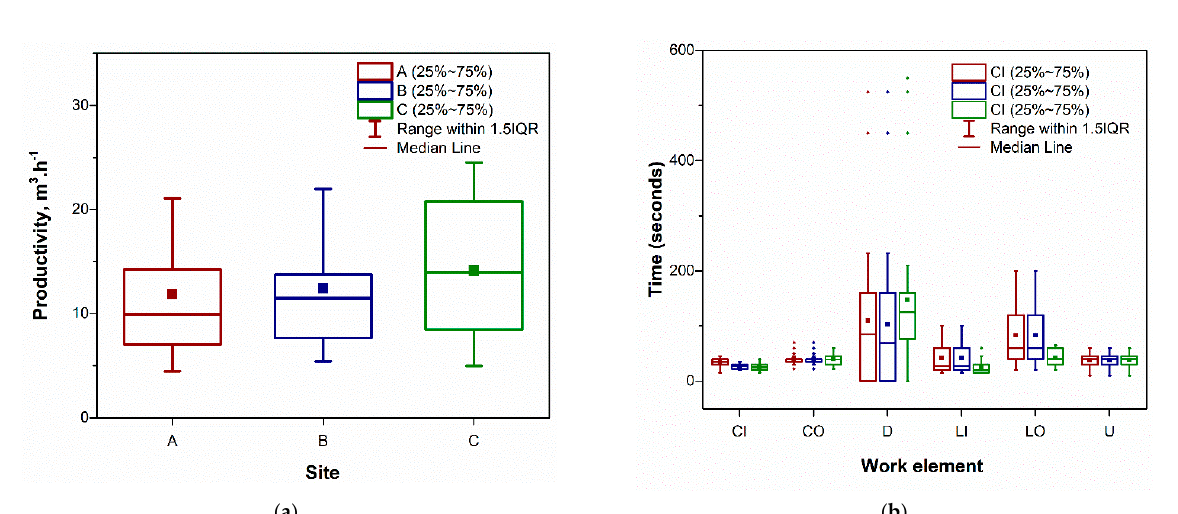
Figure 3. Summary statistics of the yarding productivity for the three corridors ( a ) and of the elemental time consumption ( b ). Legend: A, B, and C stand for corridors A, B and C; CI, CO, D, LI, LO and U work elements are defined in Section 2.3